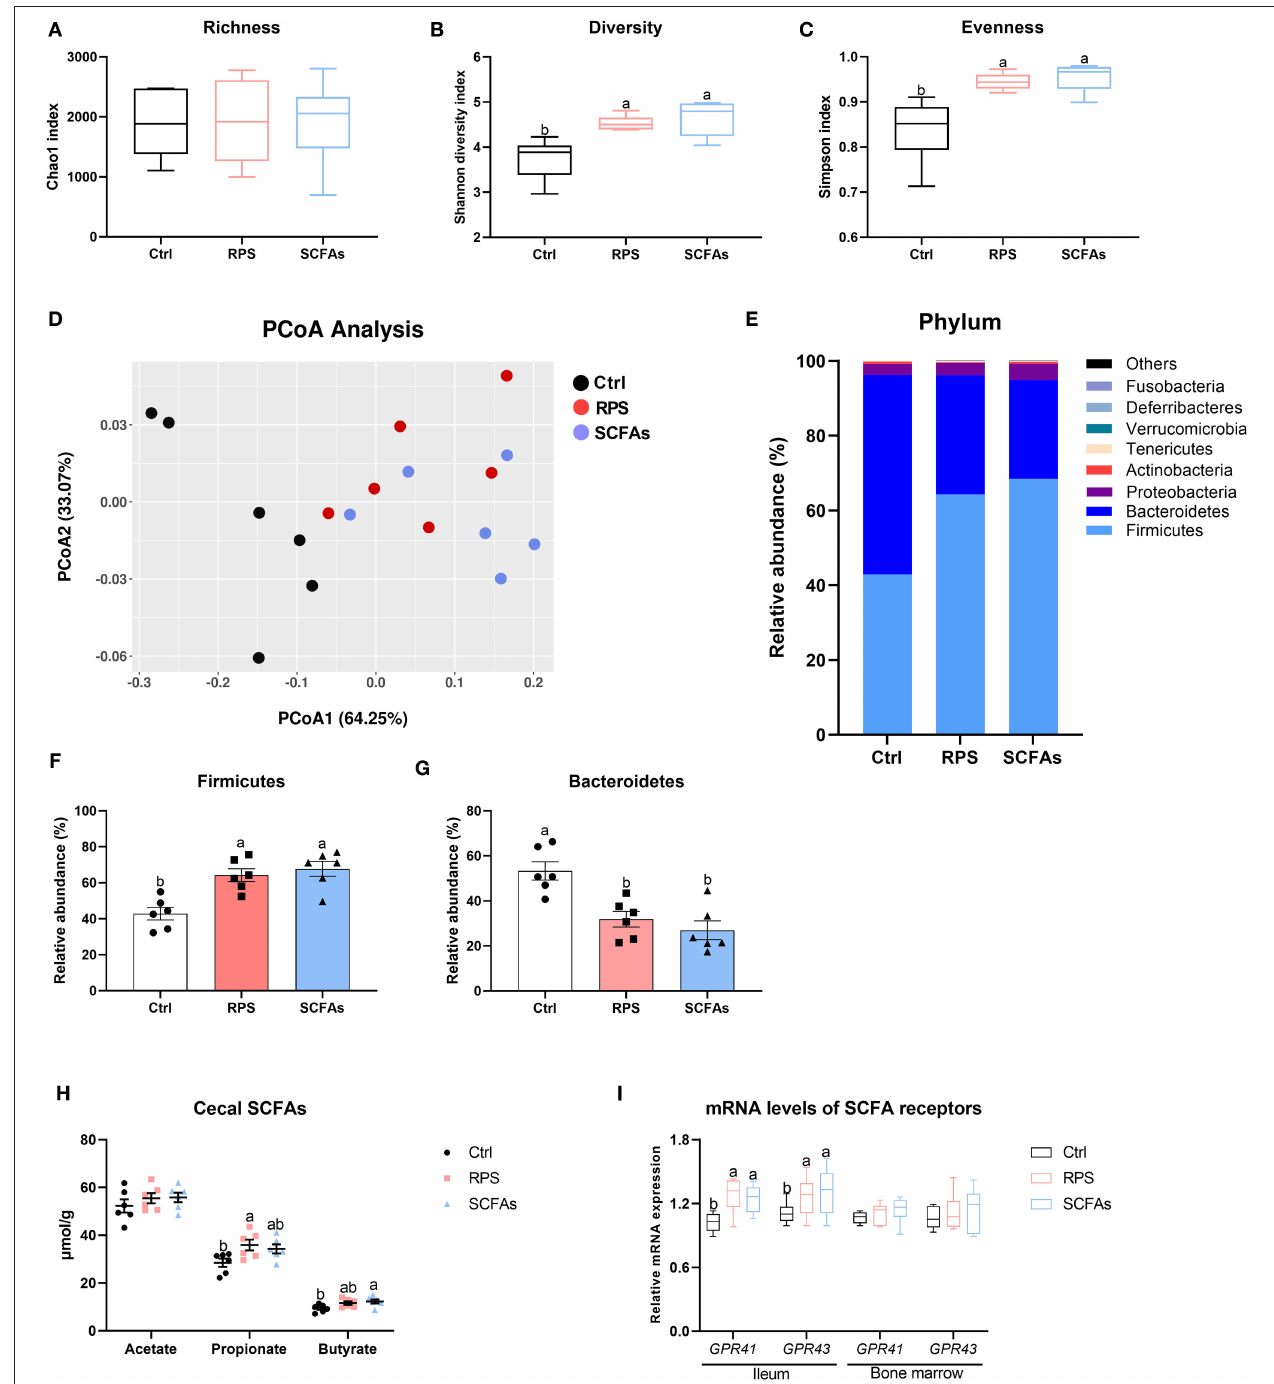
FIGURE 4 | Dietary RPS and drinking SCFAs change the microbiota composition and promote concomitant SCFAs production in the cecum of meat ducks. (A–C) Chao1, Shannon, and Simpson indexes were used to assess diversity and evenness of gut microbiota. (D) Principle coordinate analyses (PCoA) of beta diversity based on Bray-Curtis dissimilarities of bacterial operational taxonomic units. (E) Relative phylum level abundance of gut bacteria. The proportion of (F) Firmicutes and (G) Bacteroidetes. (H) SCFAs production and (I) SCFA receptor gene expression including G protein-coupled receptors 41 ( GPR41 ) and GPR43 in the ileum and bone marrow. Data are expressed as mean and standard deviation. a,b Mean values with different letters are significantly different by one-way analysis of variance followed by Tukey’s post-hoc test ( p < 0.05).